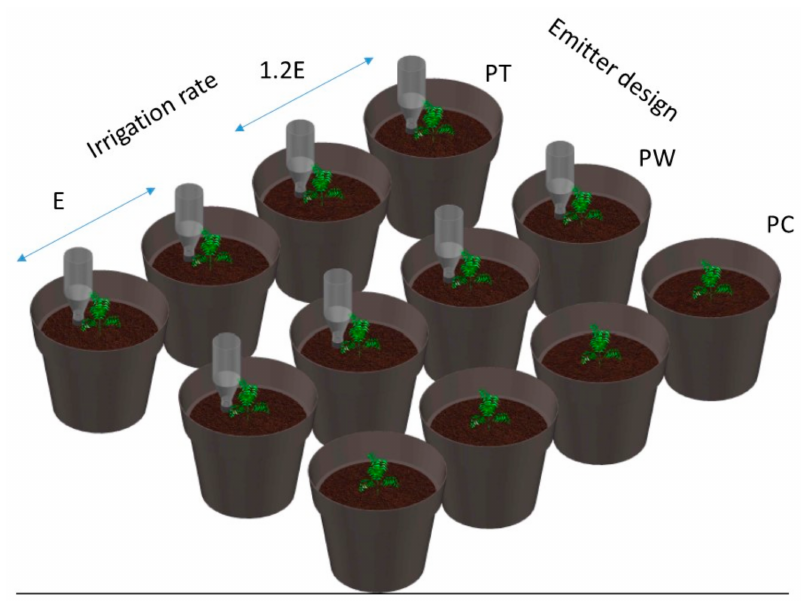
Figure 4. Testing of the pocket fertigation with various emitter designs and irrigation